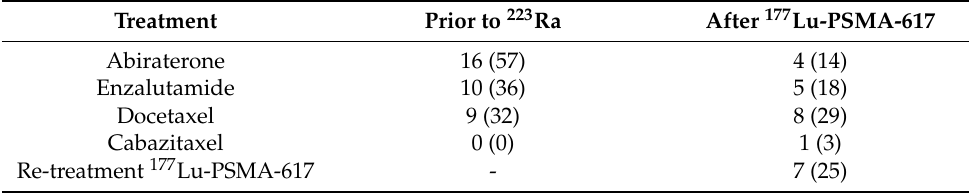
Table 1. Systemic mCRPC treatments in 28